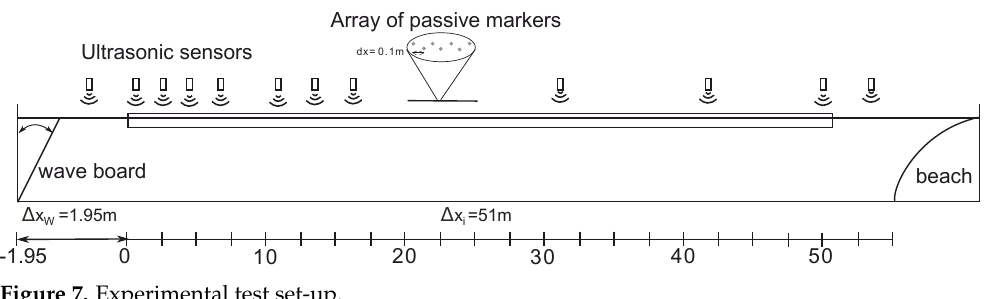
Figure 7. Experimental test set-up. The free floating ice sheet was cut free at the tank wall and moved towards the wave board to have only a small open water area of (cid:52) x w = 1.95 m in front of the ice sheet. The length of the ice sheet was (cid:52) x i = 51